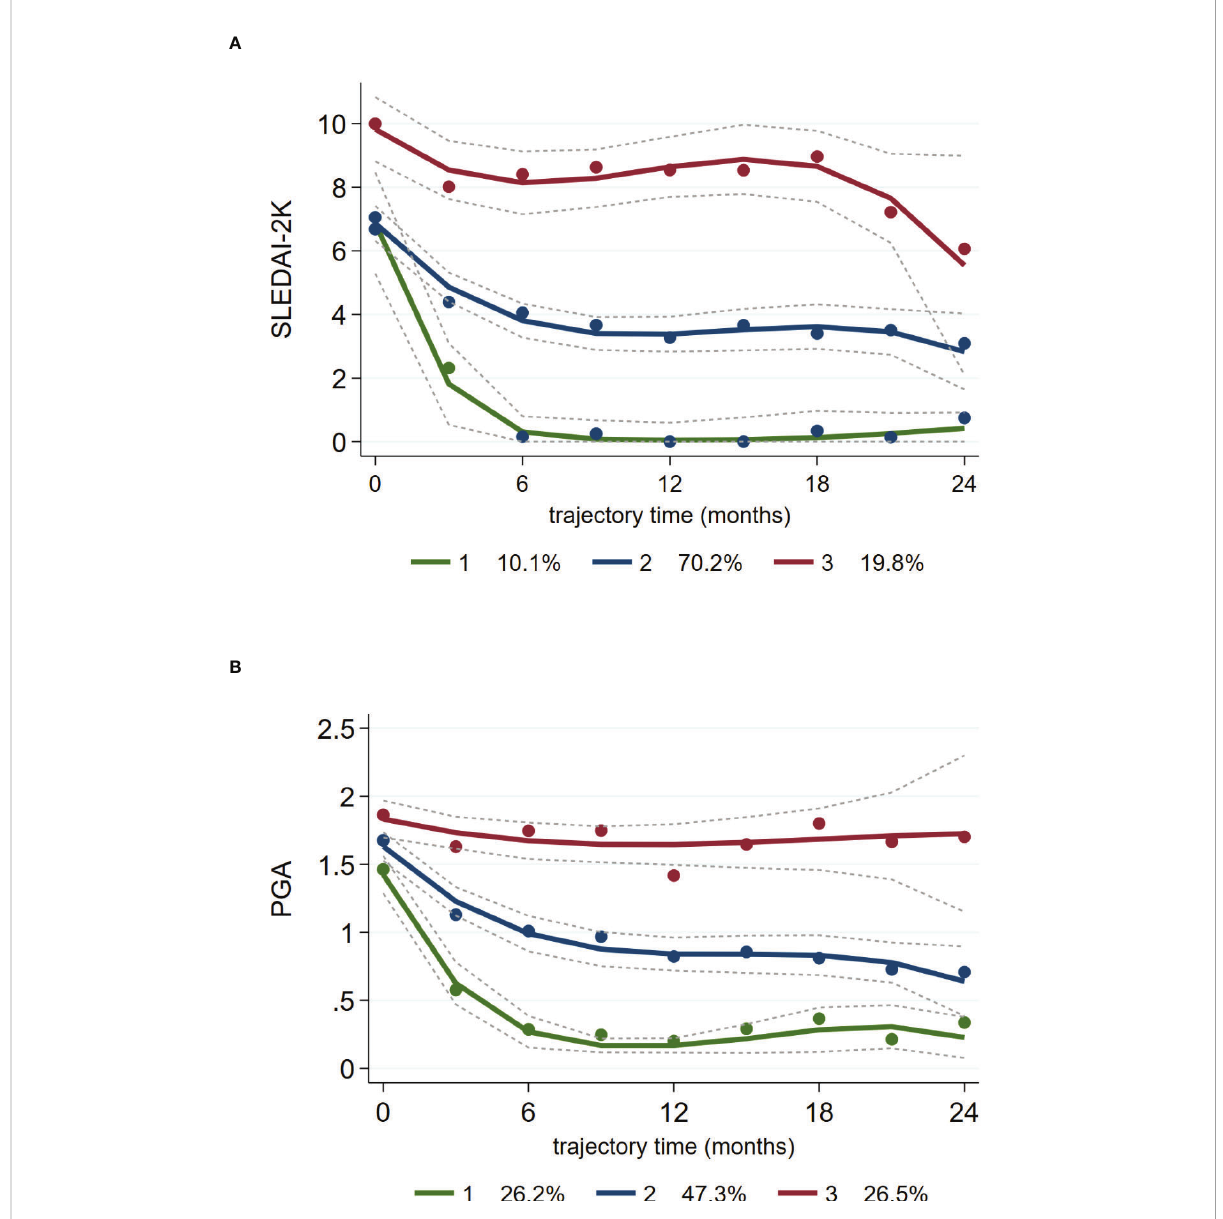
FIGURE 2 Distinct trajectories of disease activity (SLEDAI-2K, PGA) in SLE patients treated with belimumab. Group-based trajectory modelling of SLEDAI- 2K (A) and PGA (B) during belimumab treatment was performed as described in the Methods section. Solid lines (coloured) represent the parameter estimates of each model, and dashed lines represent the 95% con fi dence interval of the estimates. Dots are calculated from the actual data where each individual ’ s responses are weighted based on the posterior probabilities of group membership. Three distinct trajectories of SLEDAI-2K and PGA are indicated with different colours (top-red, middle-blue, bottom-green). The percentages at the bottom of each panel correspond to the proportion of SLE patients belonging to each